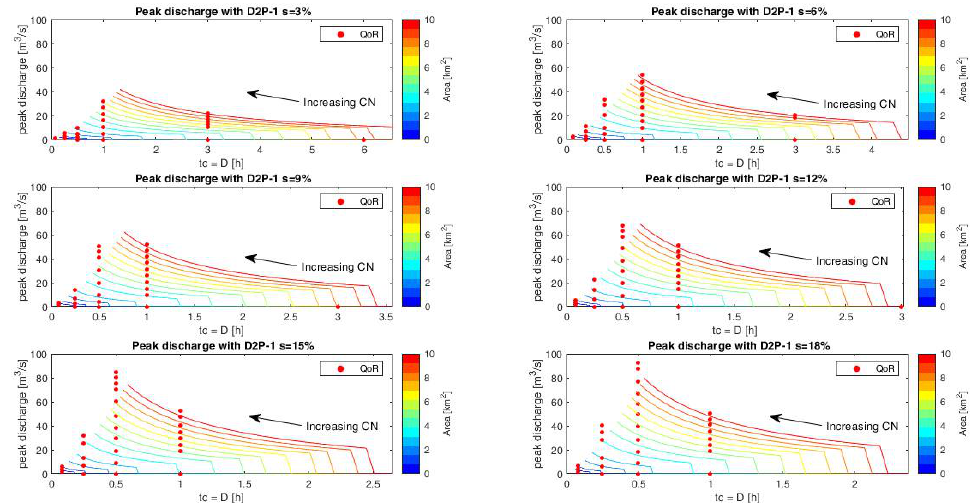
Figure 6. Peak curves obtained with D2P-1 vs. Q-Peak (red dots) evaluated with observed Rainfall.